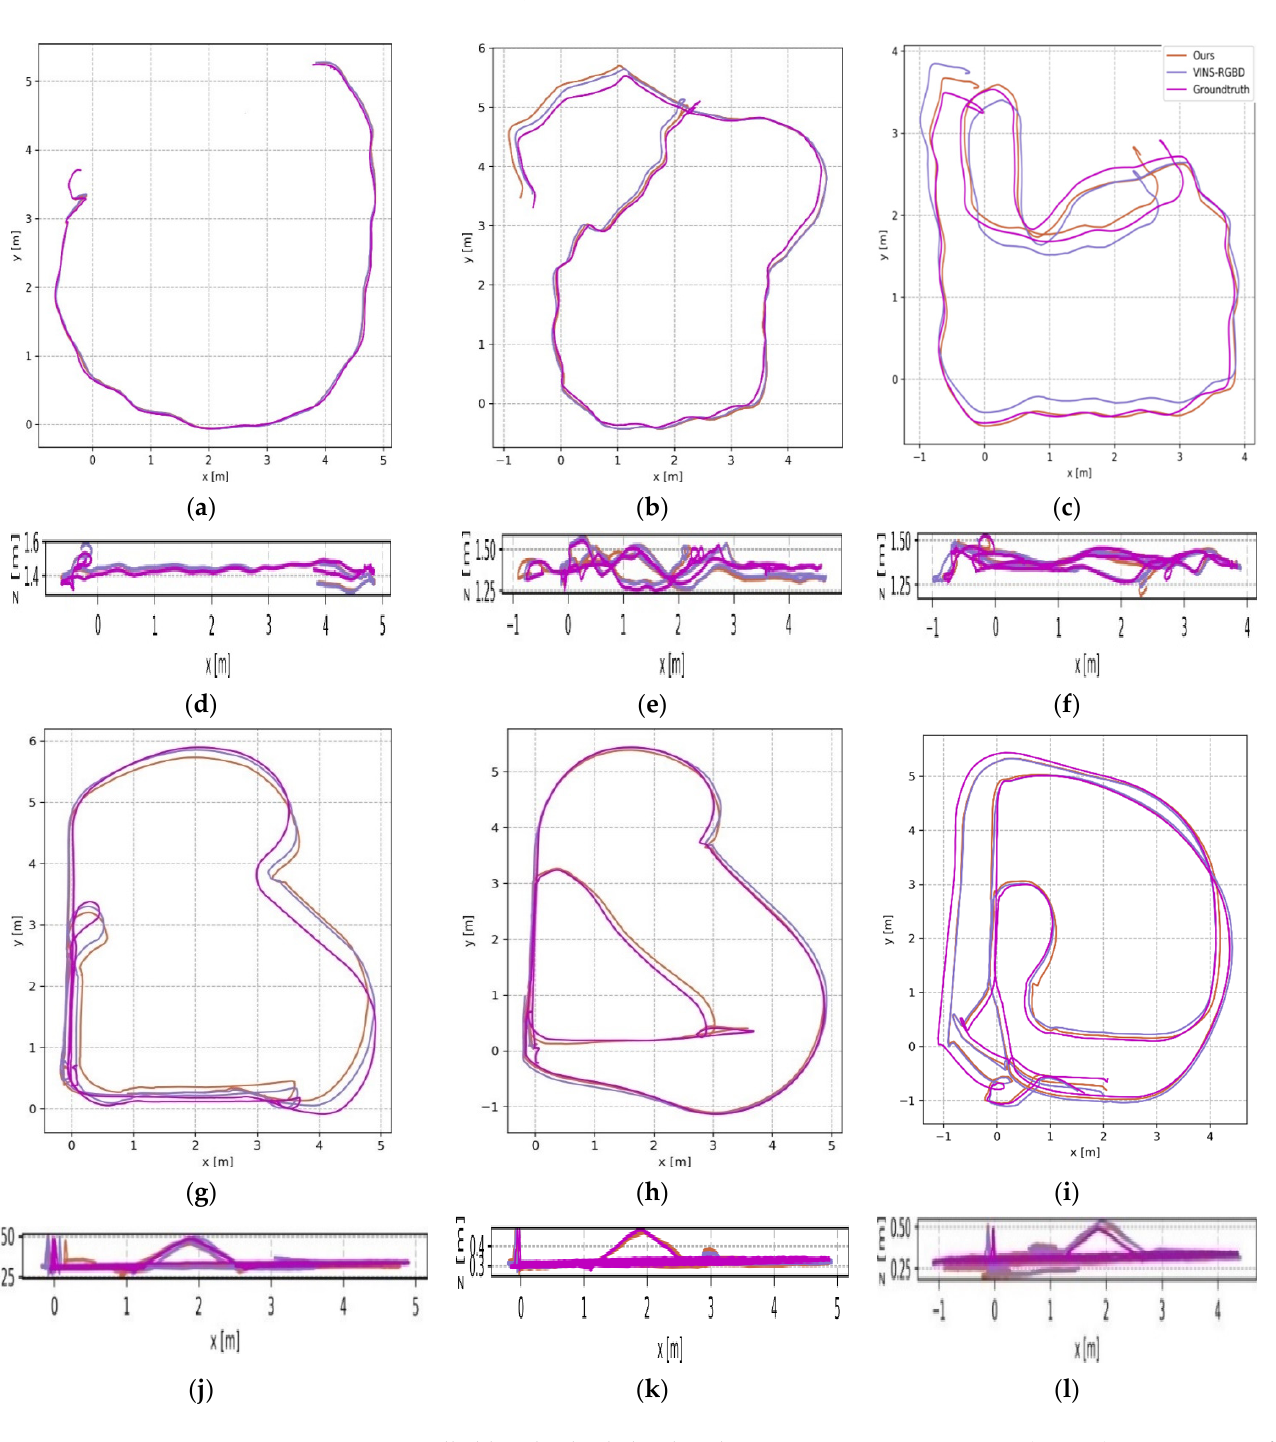
Figure 2. Handheld and Wheeled Robot datasets trajectory estimation. ( a – c , g – i ) are top view of trajectories; ( d – f , j – l ) are side view of trajectories. ( a , d ) represent the trajectory of the Handheld Simple dataset; ( b , e ) represent the trajectory of the Handheld Normal dataset; ( c , f ) represent the trajectory of the Handheld With more Rotation dataset; ( g , j ) represent the trajectory of the Wheeled Slow dataset; ( h , k ) represent the trajectory of the Wheeled Normal dataset; ( i , l ) represent the trajectory of the Wheeled Fast dataset.